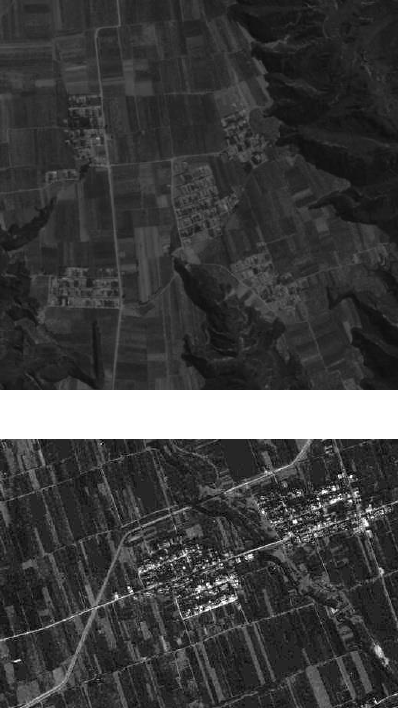
Figure 2. Label visualization for a remote sensing image: ( a ) Original image and ( b ) label image. Table 2. The proportion of residential area in our dataset.